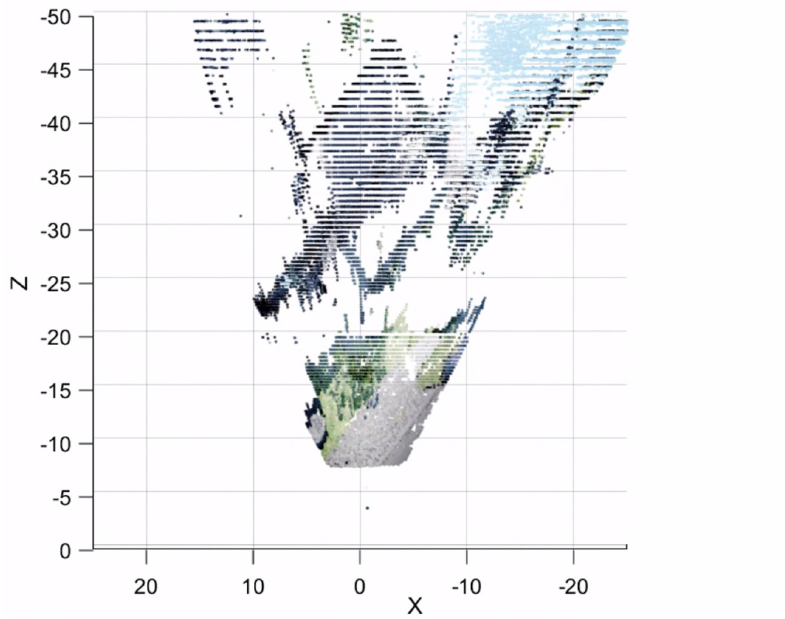
Figure 17. The resultant point cloud from baseline fusion of three baselines seen from top–down